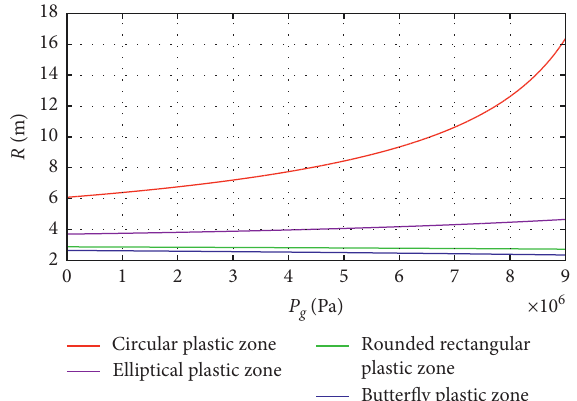
Figure 7: Variation of plastic zone radius with respect to gas pressure.